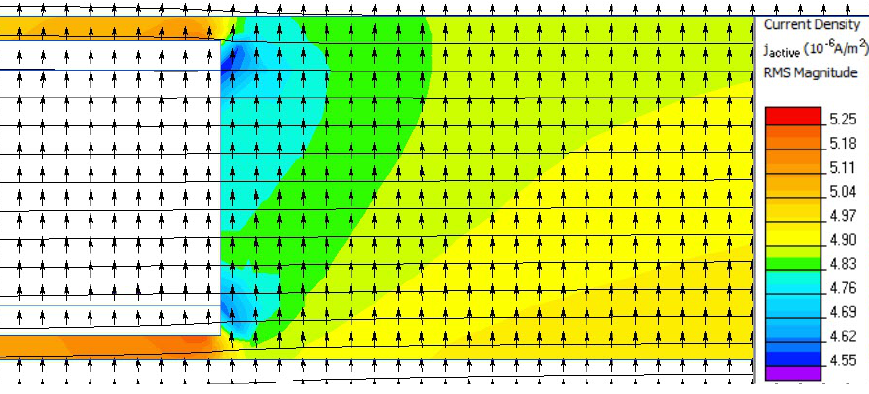
Figure 6. Current density in radial and longitudinal oil-filled gaps on a larger